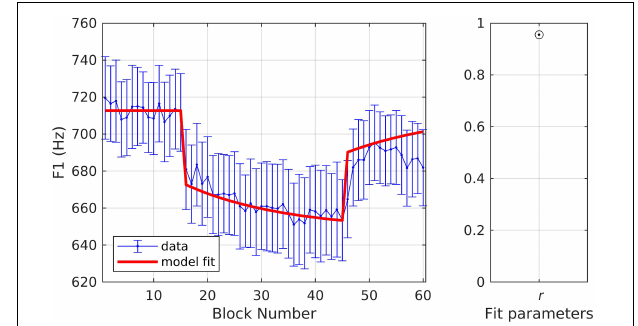
FIGURE 10 | Simulation 8: model fits of a dataset with perturbations applied to F1 and with a gradual ramp phase (data from Chao and Daliri, unpublished data). (Left) Mean and standard error of experimental data in blue; model fit in red. (Right) Fit quality and optimized parameter values ( r = correlation coefficient; α A = auditory feedback control gain, α s = somatosensory feedback control gain, and λ FF = learning rate).